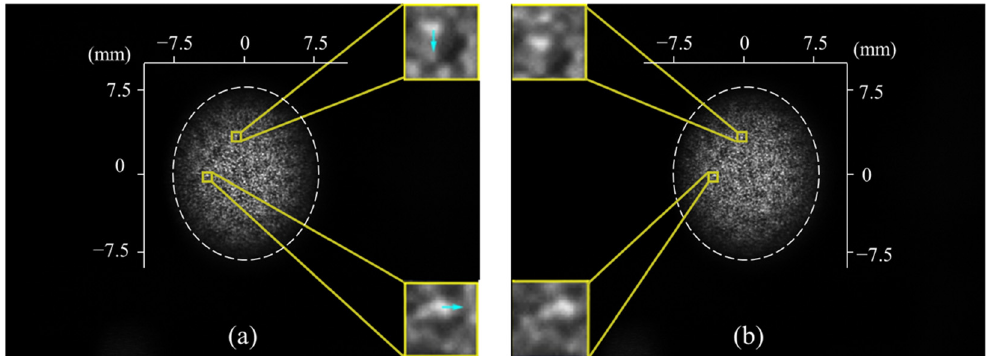
Figure 2. Typical recorded speckle pattern images ( a ) before and ( b ) after the deformation. The yellow boxes mark two pairs of subsets with 25 × 25 pixels in the two images. In the magnified images, obvious shifts along the arrows can be observed. Quantitative displacement can be calculated with DIC. The dashed white ellipses indicate the active regions for the speckle DIC processing.